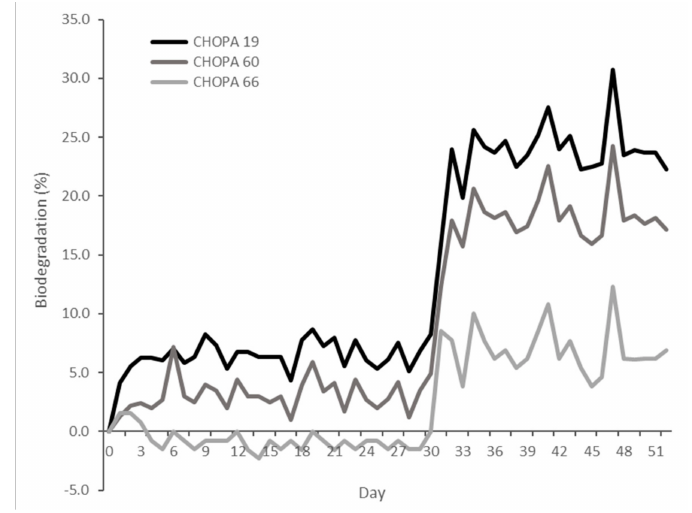
Figure 3. Biodegradation curves for CHO / PA